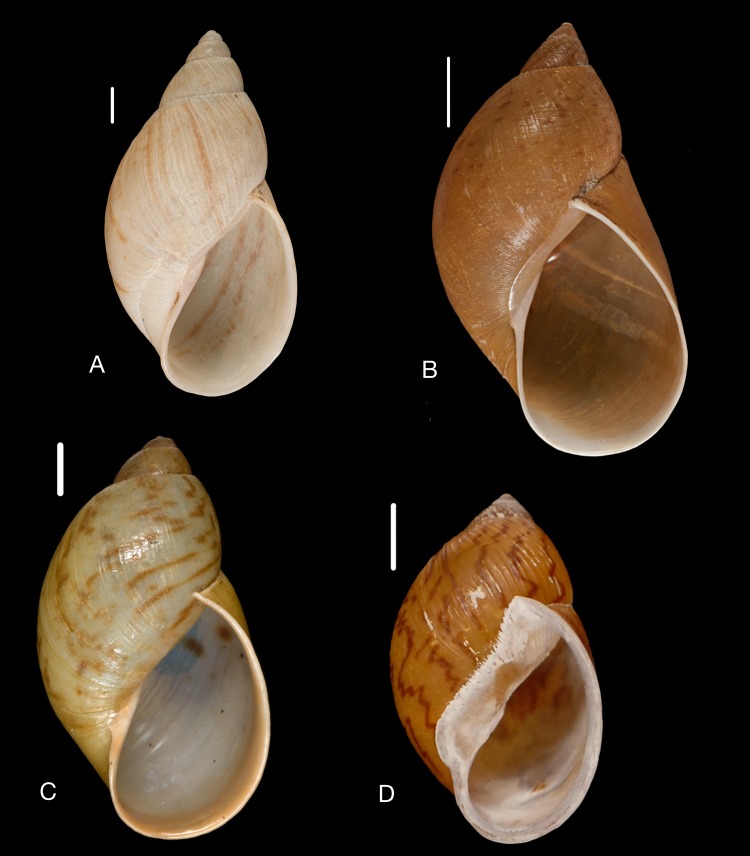
Material collected by the CCP.(A–D) Amphibulimidae. Plekocheilus (Eurytus) lynciculus (Deville & Hupé, 1850), MNCN 15.05/13389, (A) ventral view; Plekocheilus (Eurytus) taylorianus (Reeve, 1849), MNCN 15.05/13706, (B) ventral view; Plekocheilus (Eurytus) tricolor (Pfeiffer, 1853), MNCN 15.05/6943, (C) ventral view; Plekocheilus (Plekocheilus) cecepeus
Breure & Araujo, 2015, MNCN 15.05/60013H, (D) ventral view. Scale line 0.5 mm.